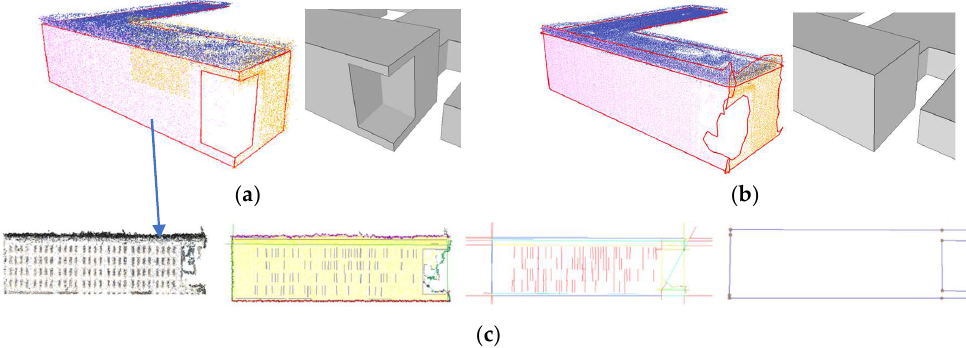
Figure 16. Model correctness comparison based on different linear primitives. The top row displays the corresponding models reconstructed from the structural contours ( a ) and the line grow-based contours ( b ), respectively. Planes inside the corner can be deduced based on the structural contours. And ( c ) displays the optimization progress of the front façade. From left to right: original points of the plane, three types of feature lines, the lines rendered by data-term, and the optimized structural contours.